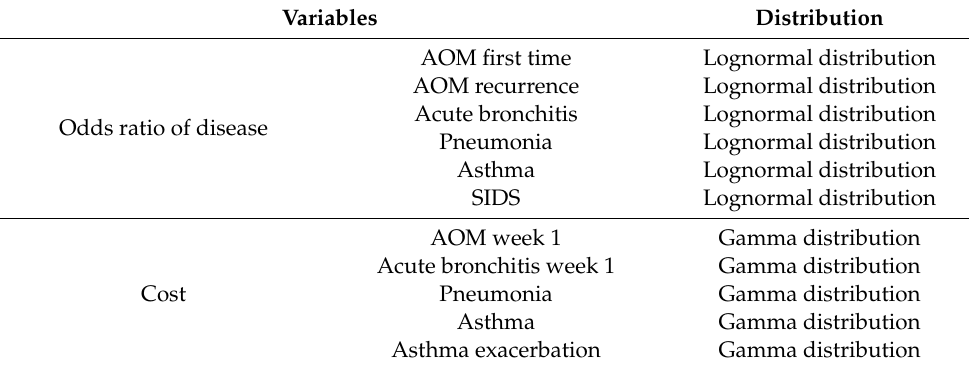
Table 1. Distribution of variables for probabilistic sensitivity analysis.